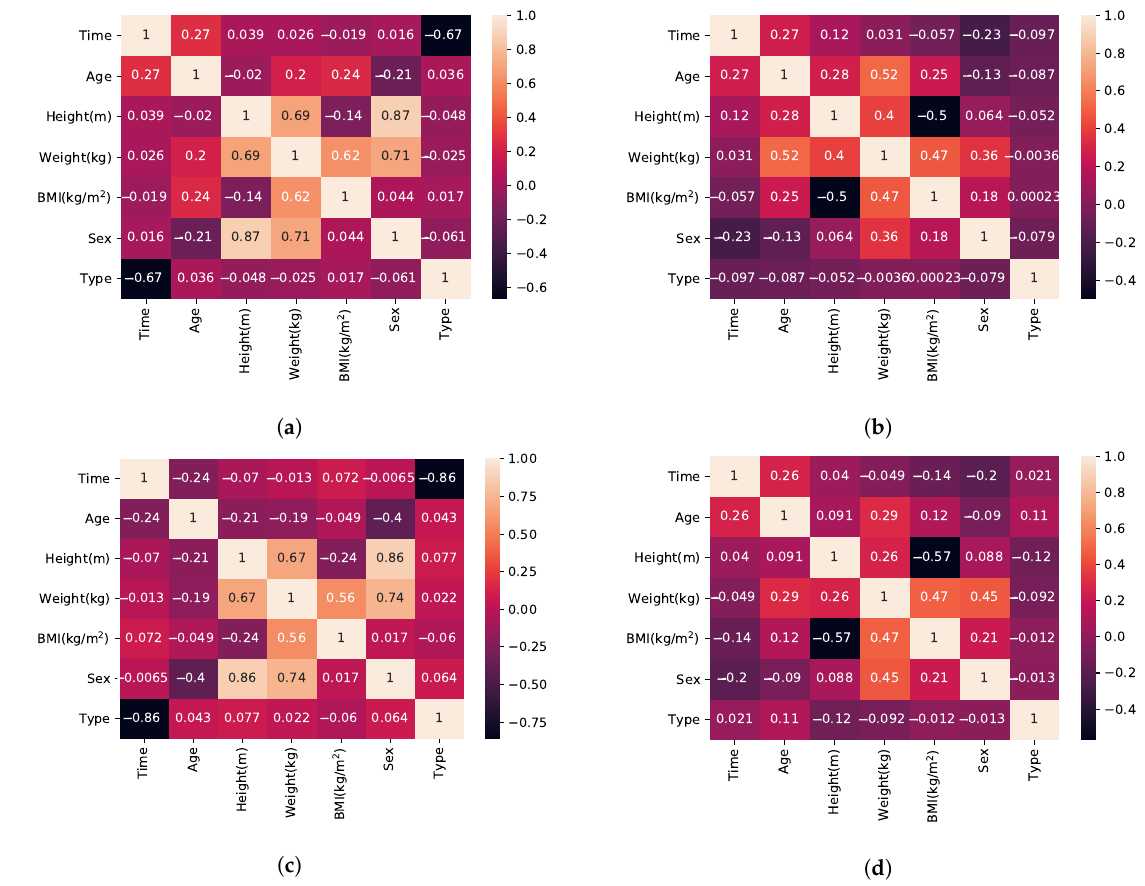
Figure 1. ( a ) Correlation matrices for Timed Up and Go (TUG) experiment, ( b ) TUG synthetic data, ( c ) Five Time Sit To Stand (FTSTS) experiment, and ( d ) FTSTS synthetic